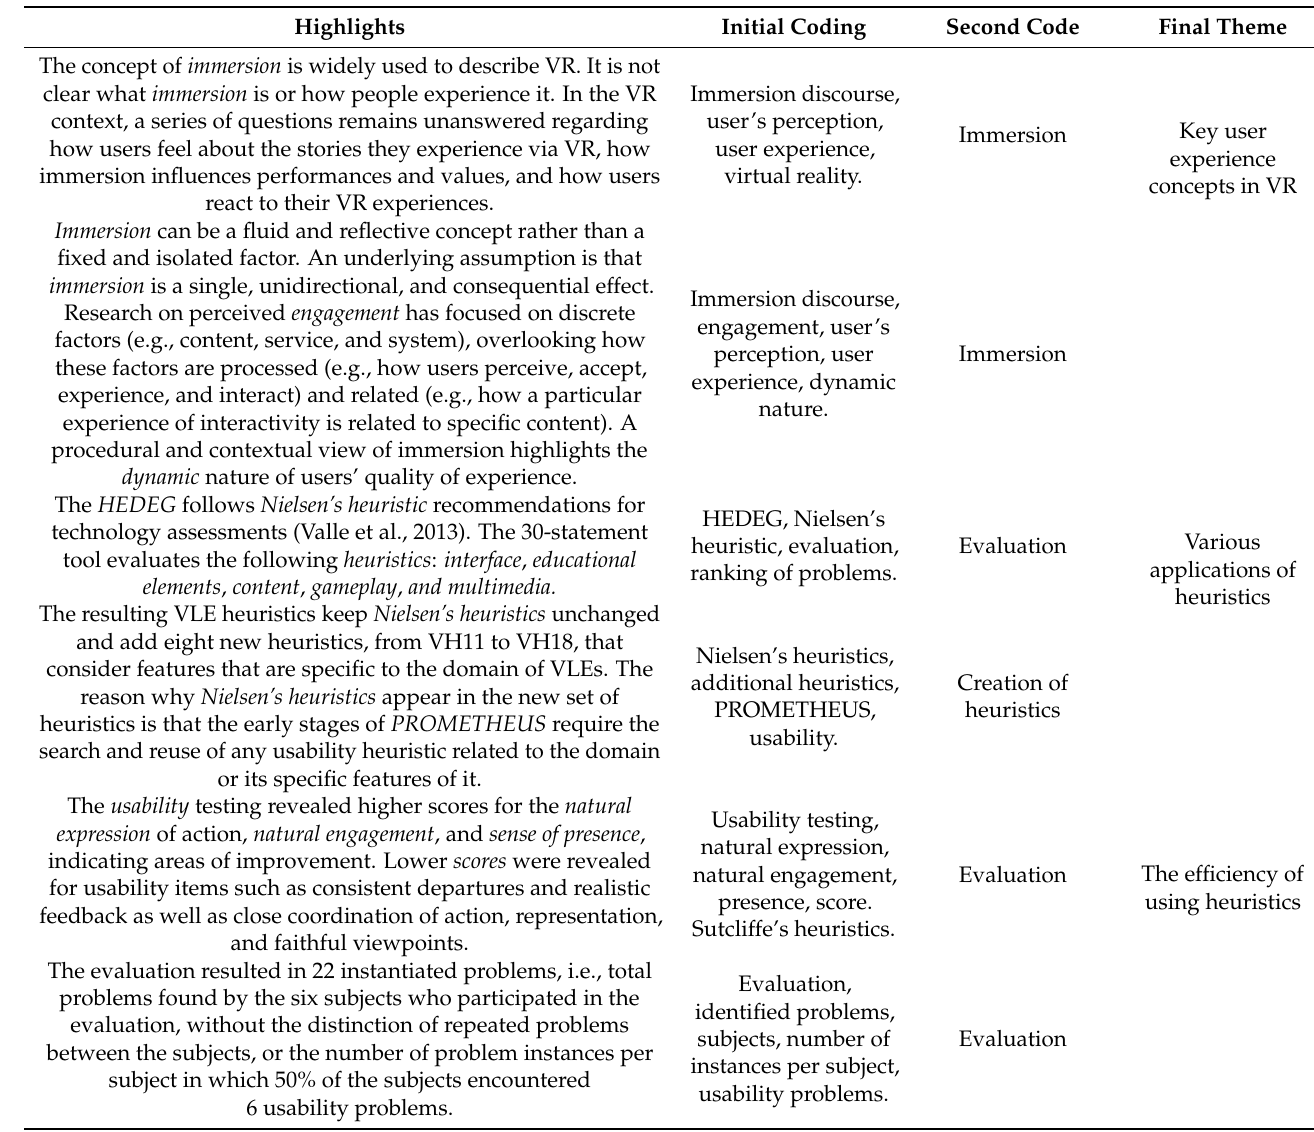
Table A1. Examples from the coding